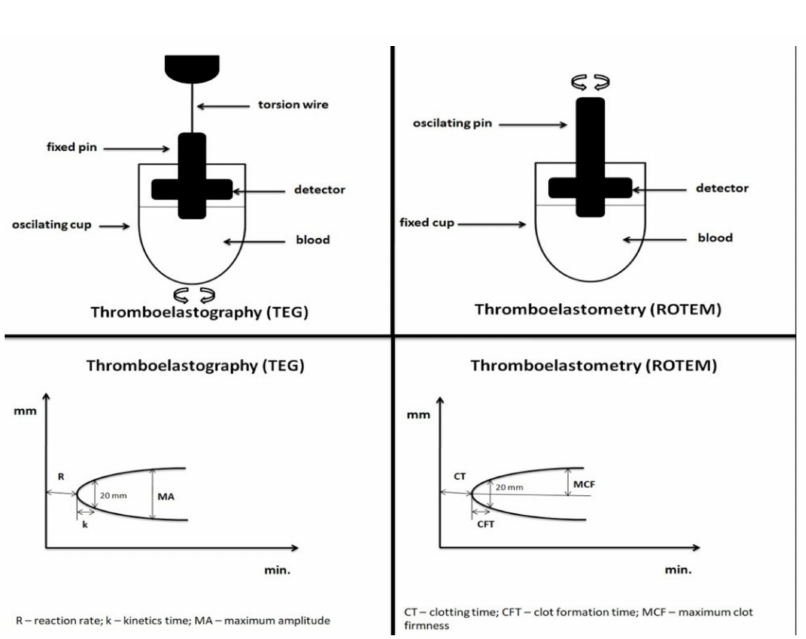
Figure 1. Thromboelastography (TEG) and rotational thromboelastometry (ROTEM). Both assays [47] graphically record kinetic changes of citrated whole blood samples during clot forming and its dissolution in the form of thromboelastogram, mapping various phases of hemostasis. The technology leans on a constantly oscillating cup/pin in a blood sample with reagents. There is no rotation blockage, if there is no clot formation. In a forming clot, there is a rotation blockage due to a link between the cup wall and pin. Thus, free rotation corresponds to an amplitude of 0 mm and no rotation corresponds to an amplitude of 100 mm. The interpreting software determines clot formation parameters